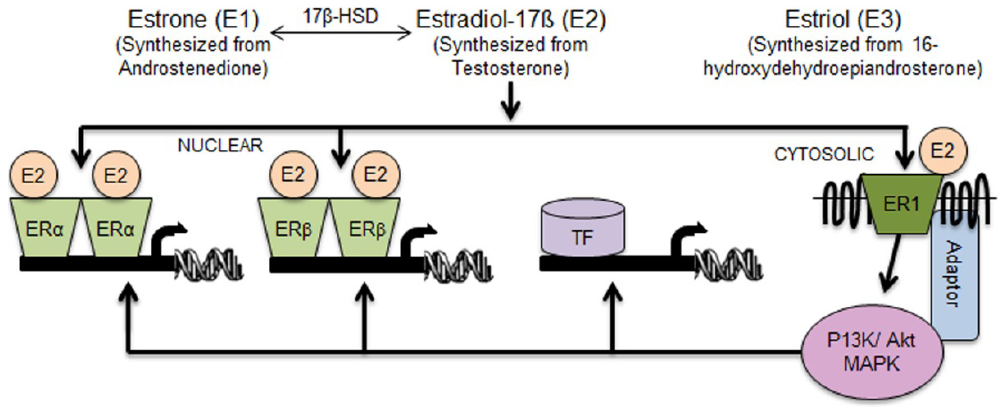
Figure 1. Direct and indirect mechanisms for the regulation of gene expression by estrogen. E1, E2, and E3 are the three predominant naturally occurring forms of estrogen. 17 β -HSD catalyzes the reversible conversion of E1 and E2. Three types of estrogen receptors were identified: nuclear receptors ER α and ER β , as well as transmembrane G-protein coupled estrogen receptor ER1 (alias GPER). The classical pathway for direct gene transcription is the binding of E2 to ER α and ER β and activation of target genes containing ER response elements (ERE) (Vertical signaling). Activation of ER1 by E2 can in turn activate the classical ER α and ER β pathways through the signaling cascade governed by PI3K/AKT protein kinases (Vertical signaling). Alternatively, PI3K/AKT triggers activation of other transcription factors (TF) that do not contain ERE (Horizontal signaling). 17 β -HSD, 17 β -Hydroxysteroid dehydrogenase; ER α , estrogen receptor alpha; ER β , estrogen receptor beta; GPER, G-protein-coupled estrogen receptor one (alias ER1, GPER or GPR30); P13K, phosphatidylinositide 3-kinase/protein kinase B; AKT, protein kinase